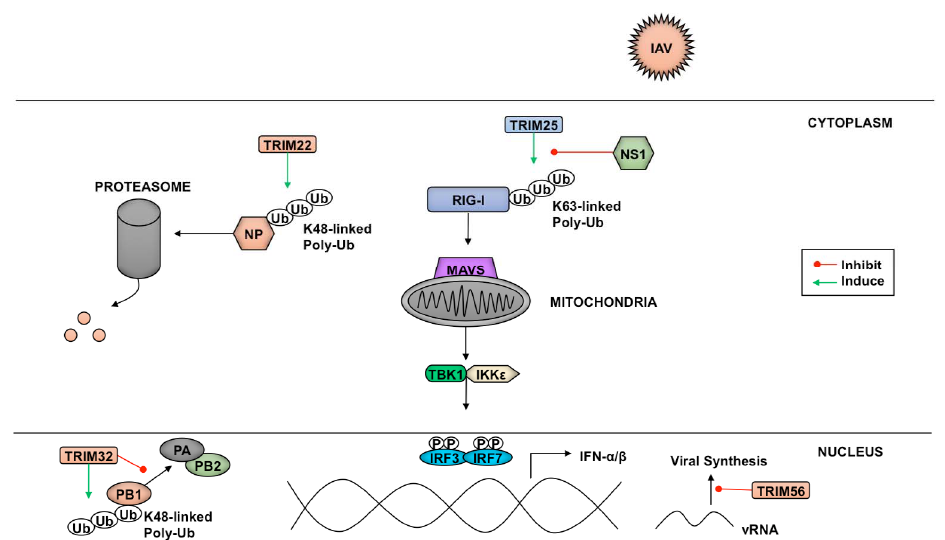
Figure 4. Effects of TRIMs on influenza virus components and IFN antagonism. The